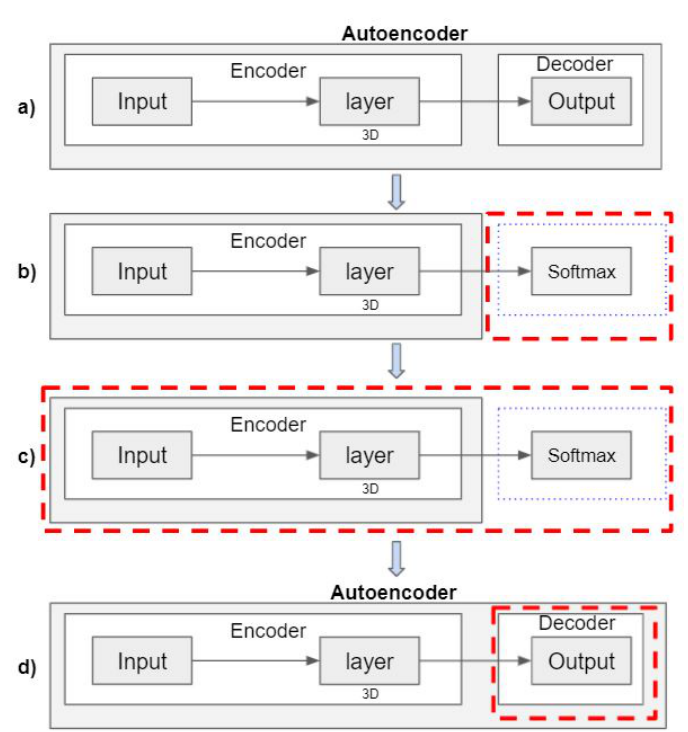
Figure 3. Fine-tuning process. ( a ) Represents the autoencoder architecture. ( b ) Represents the encoder with an additional softmax layer. In this stage, we freeze the encoder layers and fit, allowing the gradient to backpropagate only through the softmax layer. ( c ) We again train the encoder and softmax layer, unfreezing the encoder layers. ( d ) We remove the softmax layer and we train the encoder and decoder freezing the encoders